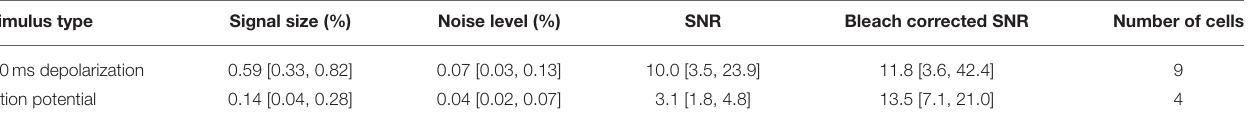
TABLE 1 | Signal, Noise, and SNR